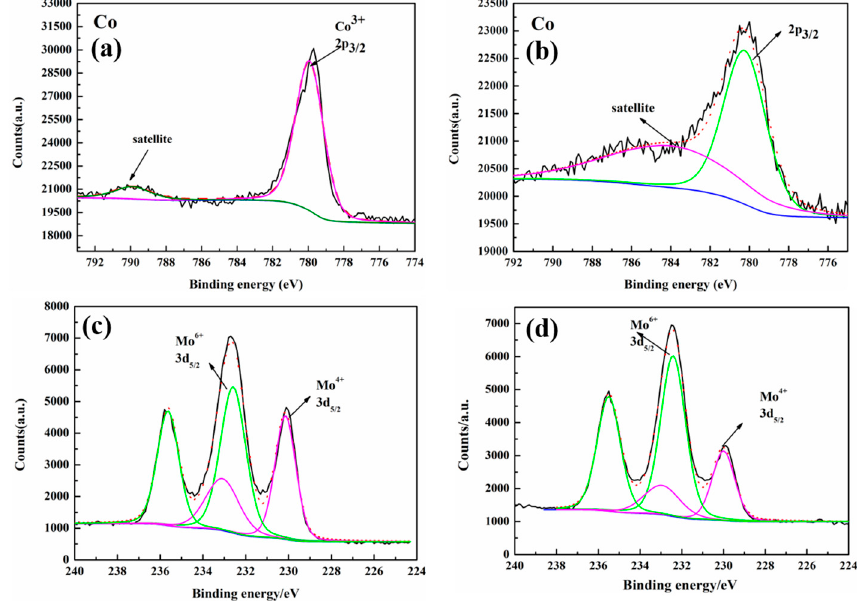
Figure 2. XPS spectra of Co in ( a ) the doped precursor, and ( b ) Li 2 Mo 0.90 Co 0.10 O 3 and the XPS spectra of Mo in ( c ) Li 2 MoO 3 and ( d ) Li 2 Mo 0.90 Co 0.10 O 3 .